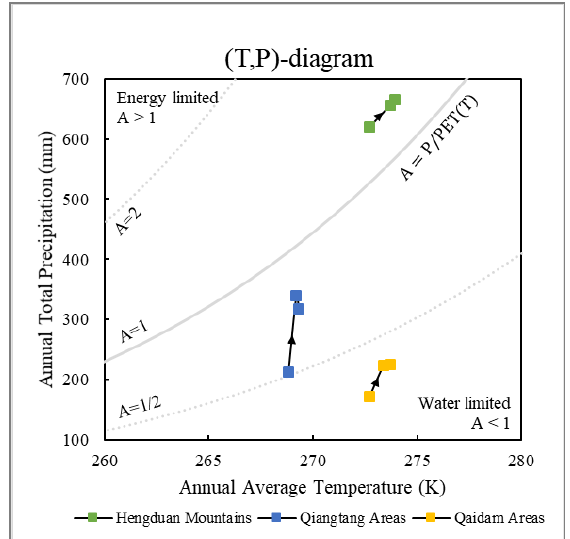
Figure 4 . The hydro-thermal climatic conditions in three climatic regions and their decadal variations from 1980s to